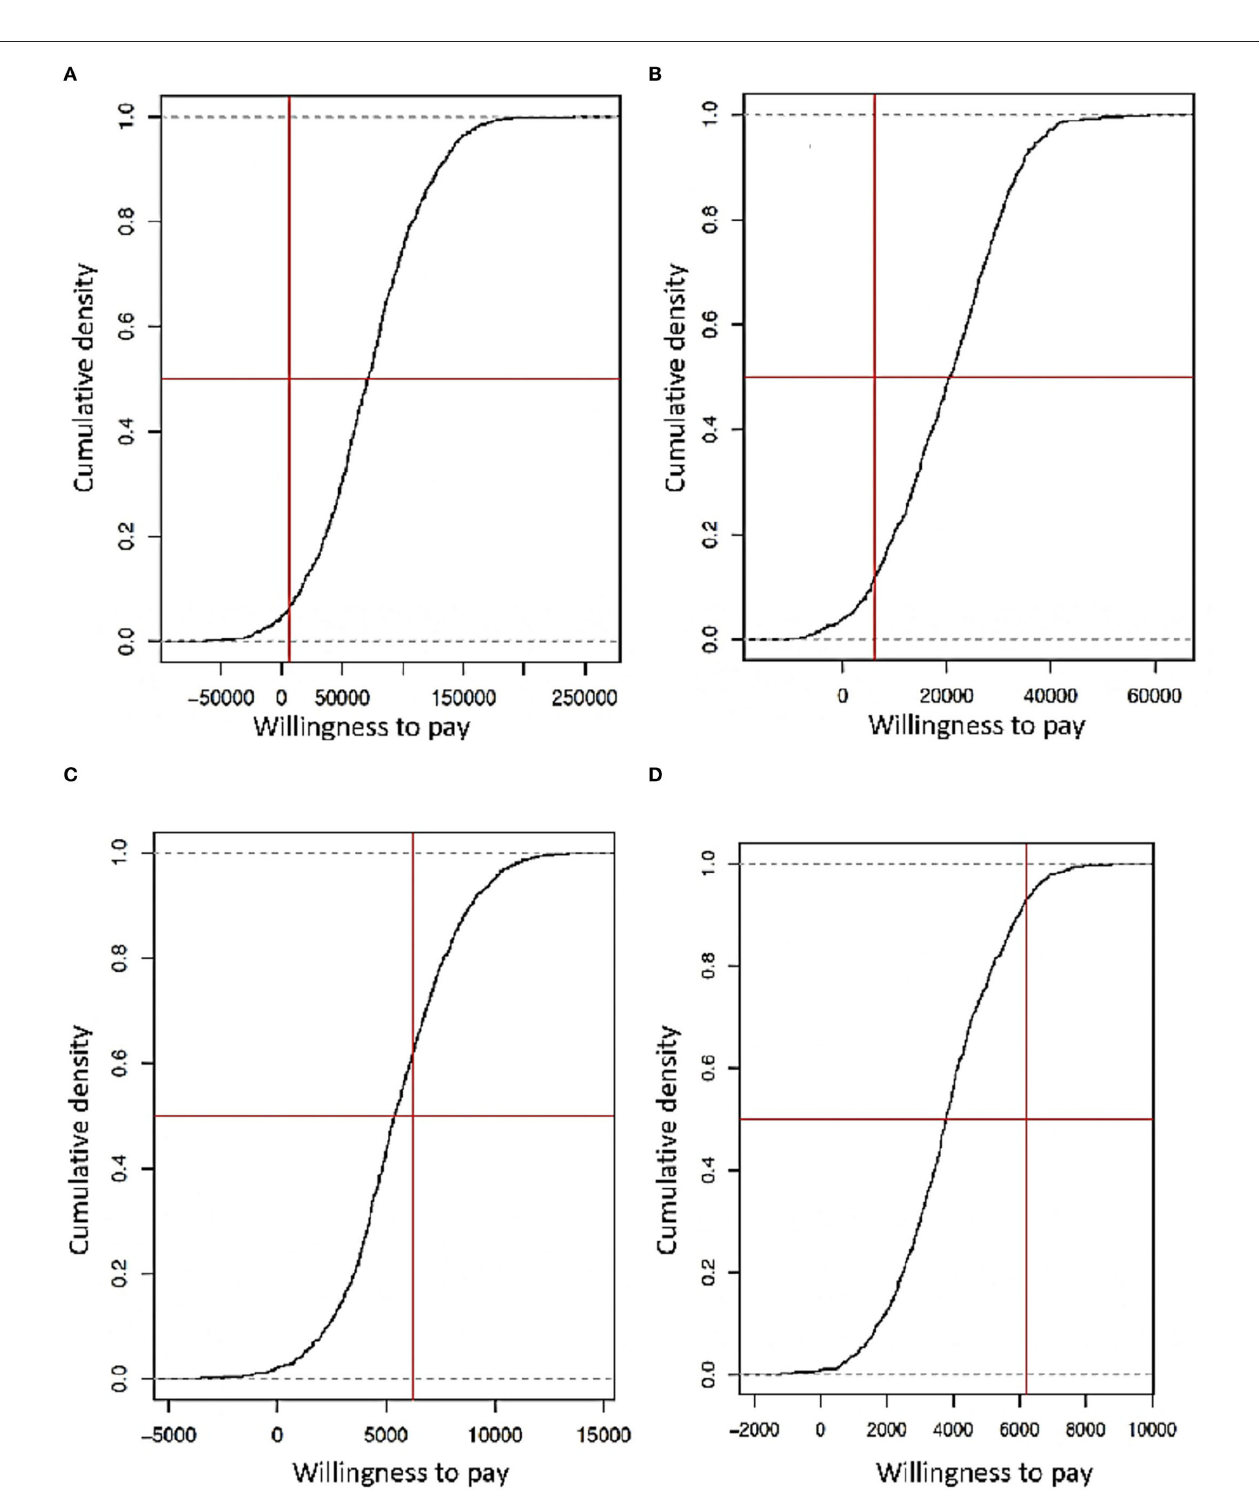
FIGURE 7 | (A) Simulation of the capacity of willingness considering the use of only ART with deterministic data. (B) Simulation of power of willingness viewing the using singular ART with stochastic data. (C) Simulation of the capacity of willingness considering the use of PrEP like prevention with deterministic data. (D) Simulation of the capacity of willingness considering only PrEP like prevention with stochastic data (the Y-axis is the probability that an expending would be accepted and forming part of the implementation strategy, X-axis represents how much a government can spend on a strategy according to its GDP, represented by a vertical red line, and the horizontal red line is the logistic regression threshold of